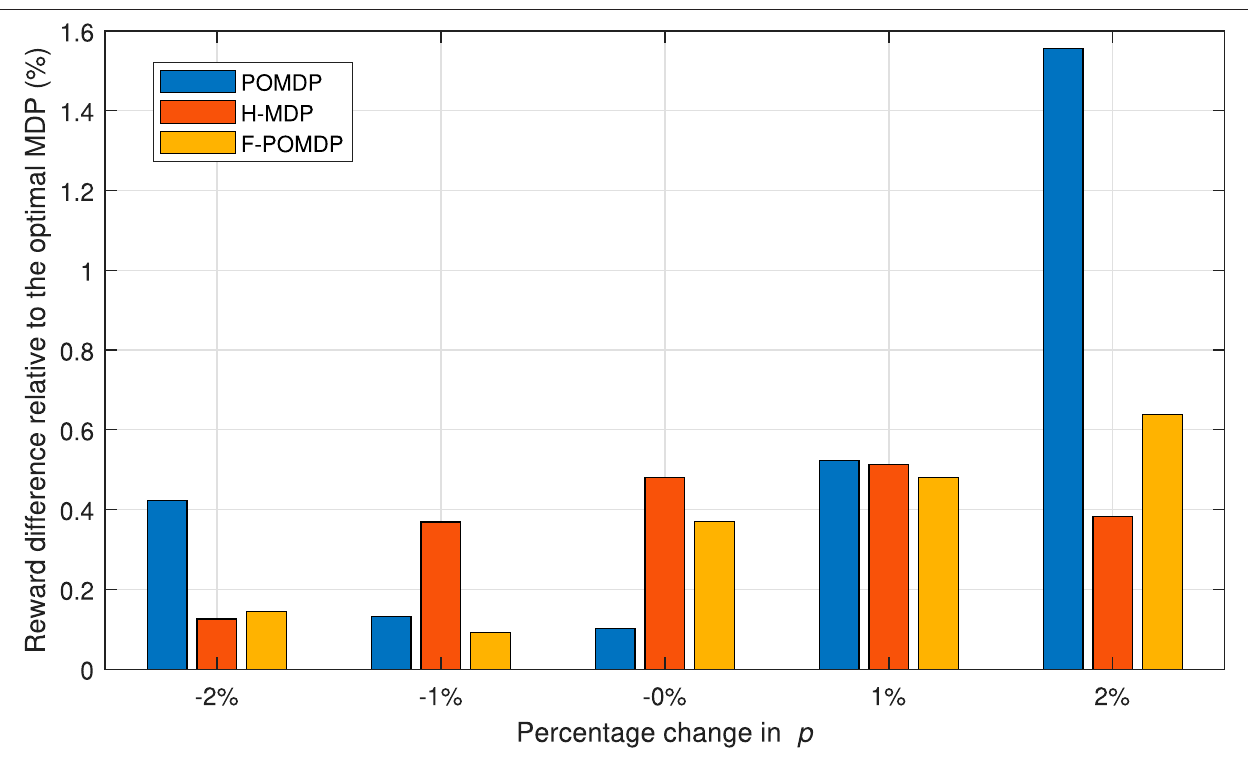
Frontiers in Communications and Networks |